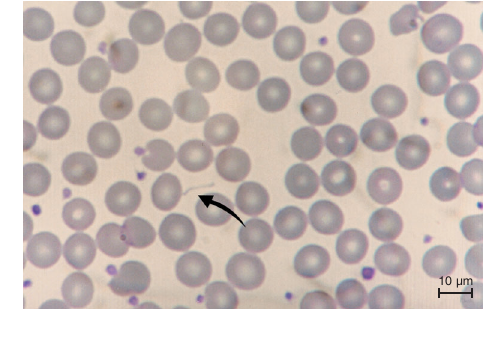
Figure 2. Microorganisms (ar- row) in the peripheral blood of a patient with Lyme disease-like syndrome (Panoptic staining, 1000X, magnification bar = 10